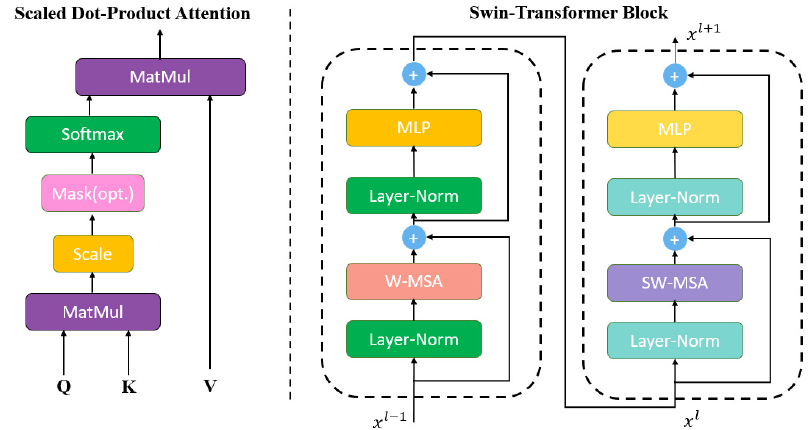
Figure 6. The structure of self-attention mechanism and block in swin-MFA.